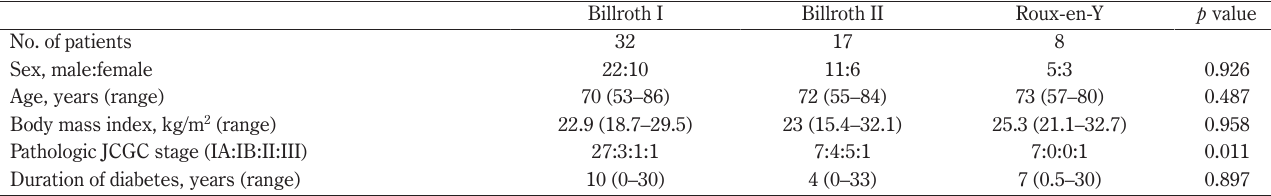
Table 2 Characteristics and demographic data of patients